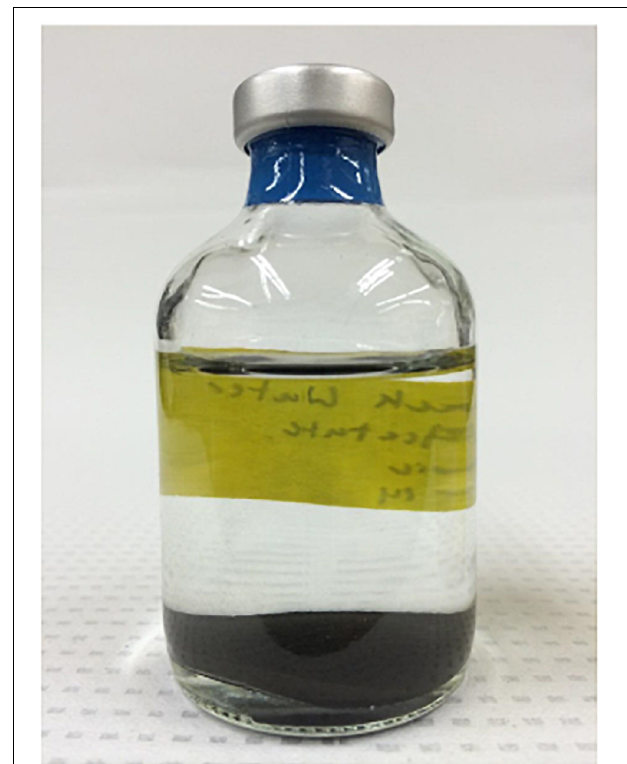
FIGURE 1 | Serum bottle containing produced water as prepared for anoxic